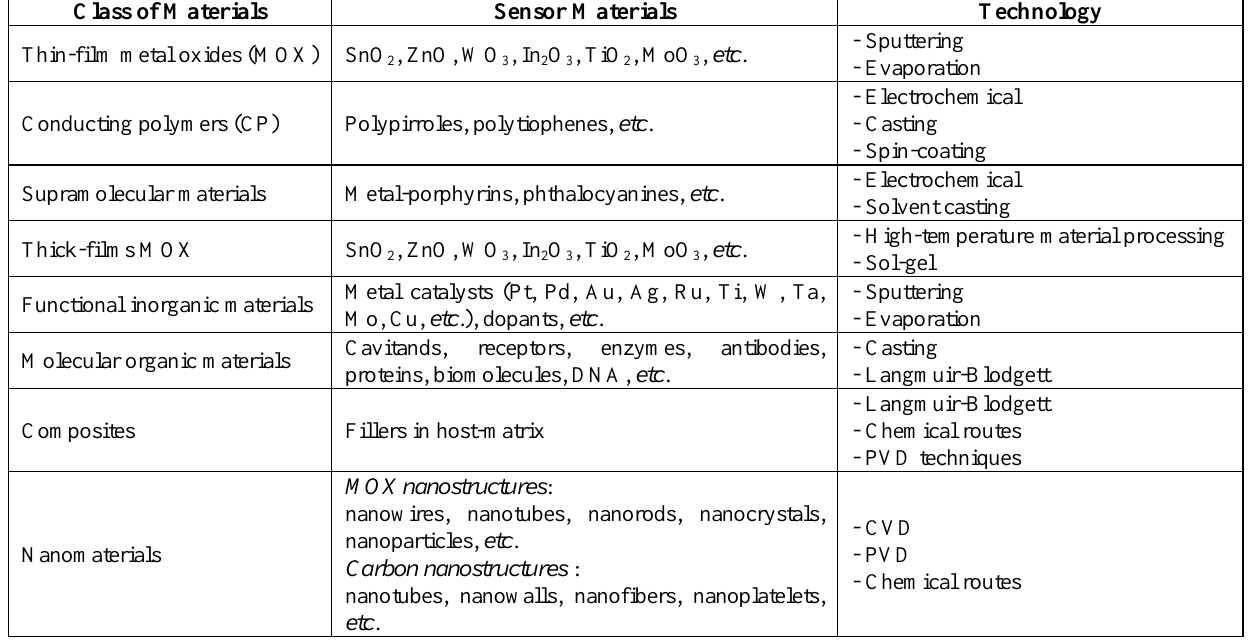
Table 1. Most used gas-sensitive materials for chemical